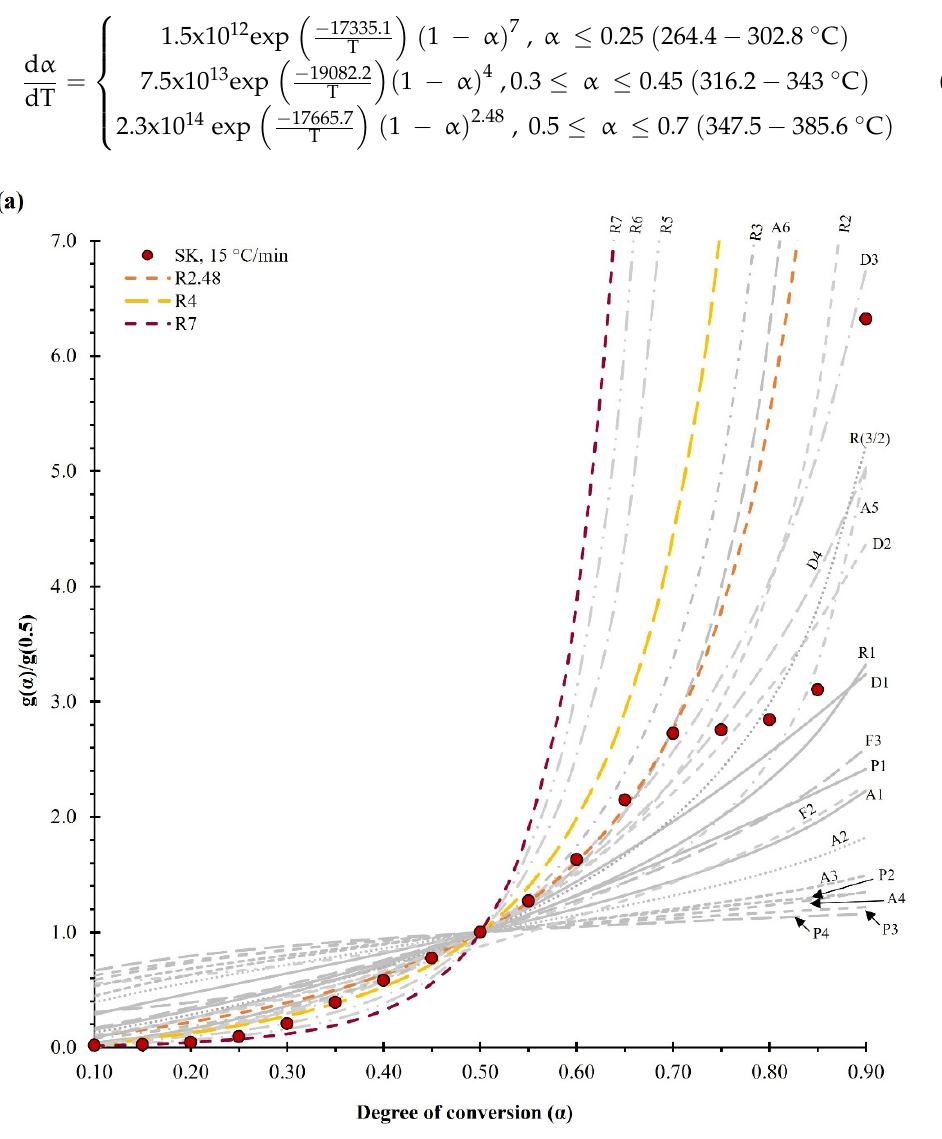
Figure 5. ( a ) Reaction models using generalized master plot method (g( α )/g(0.5) vs. α ), and ( b ) ex- perimental and theoretical curves (g( α )/g(0.5)). 2.4. Thermodynamics Analysis The thermodynamic parameters, enthalpy, Gibbs free energy, and entropy were plot- ted as a function of the degree of conversion ( α ) (Figure 6), and the numerical values are shown in Table 4. All these calculations were performed using the apparent activation energy calculated from the SK method and the pre-exponential factor using the Kissinger method at 15 °C/min. The evaluation of thermodynamic properties is essential to define the operating conditions of a process, and in this sense, the Δ H is defined as the energy used in the conversion of biomass into various pyrolytic products. The average value ob- tained was 117.4 kJ/mol. In addition, the difference between E A and Δ H is the energy be- tween the reactant and the activated complex. It is called the “potential energy barrier”